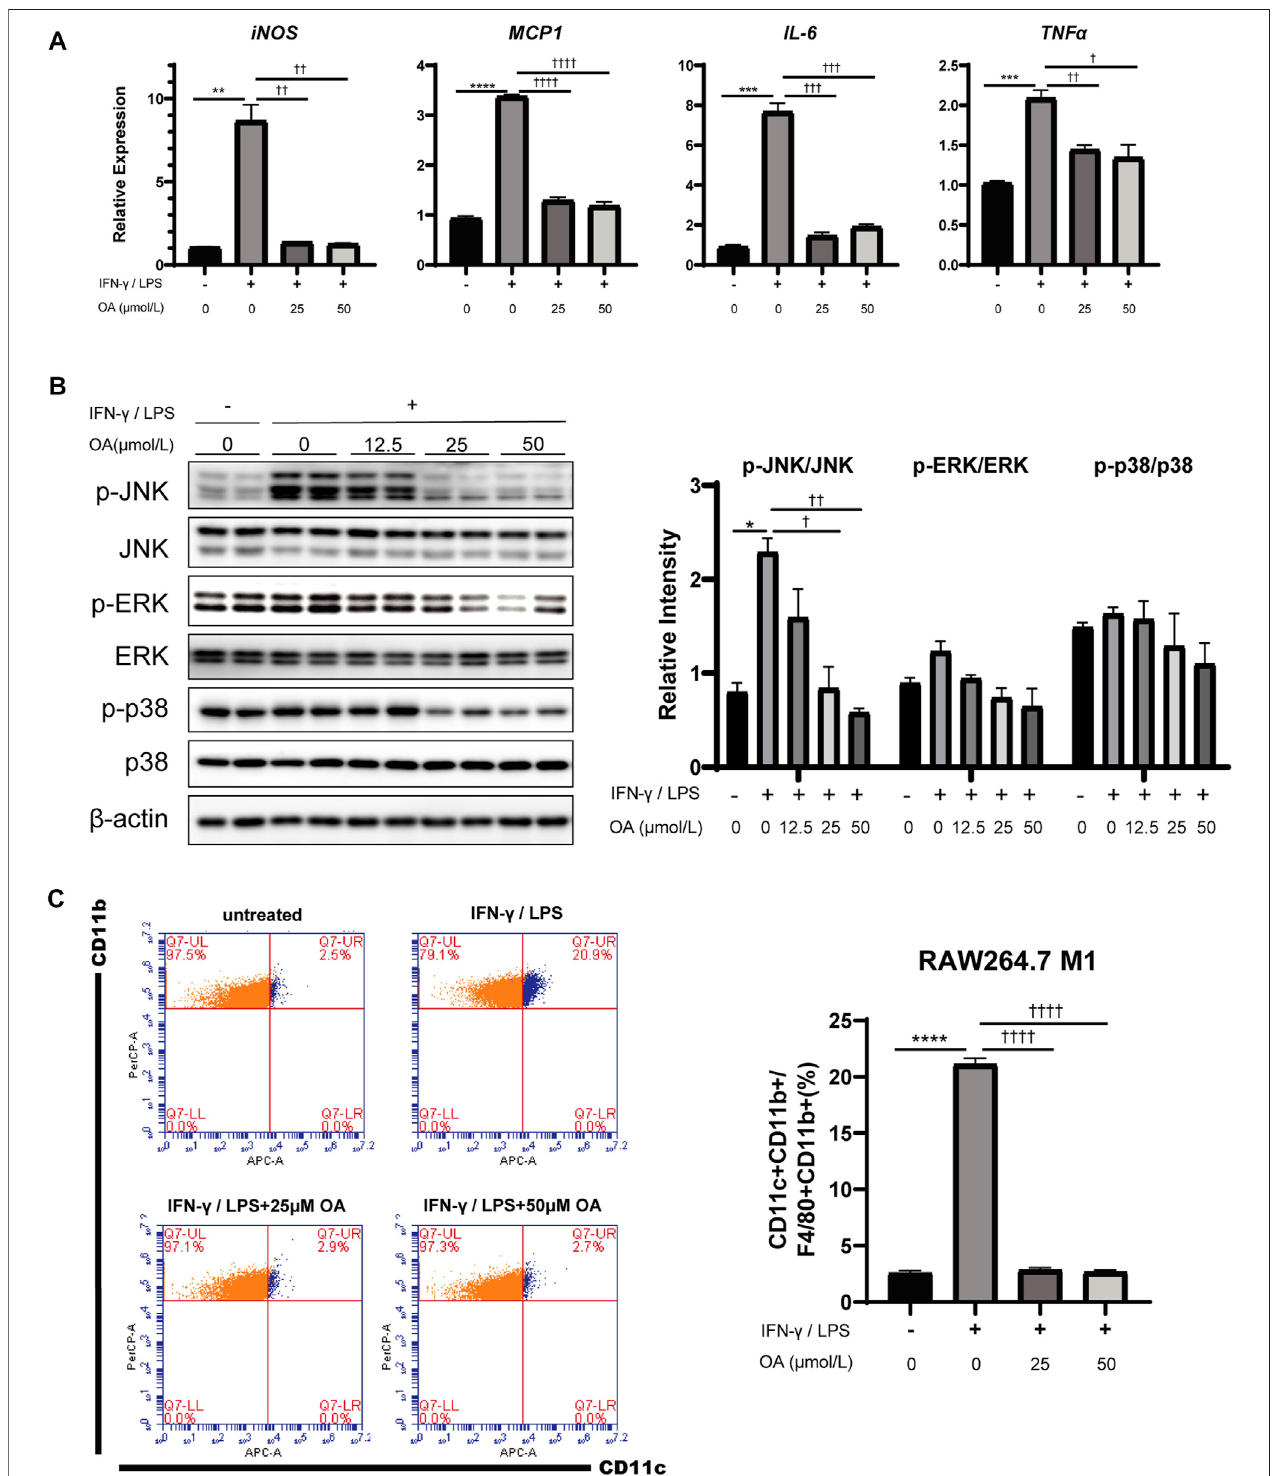
FIGURE 4 | OA reduces in fl ammation and M1 polarization in RAW264.7 macrophages stimulated by IFN- γ /LPS. (A) OA suppresses the increase of IFN- γ /LPS induced M1 markers mRNA expression in RAW264.7 macrophages ( n (cid:1) 3). (B) WB of phosphorylated p38 MAPK (p-p38 MAPK), phosphorylated JNK (p-JNK), phosphorylated ERK (p-ERK), and their total proteins in RAW264.7 macrophages. (C) FCM analysis of the M1 ratio of RAW264.7 macrophages (n (cid:1) 3). ** p < 0.01, *** p < 0.001, **** p < 0.0001 vs. control incubations, † p < 0.05, †† p < 0.01, ††† p < 0.001, †††† p < 0.0001 vs. IFN- γ /LPS stimulated incubations.